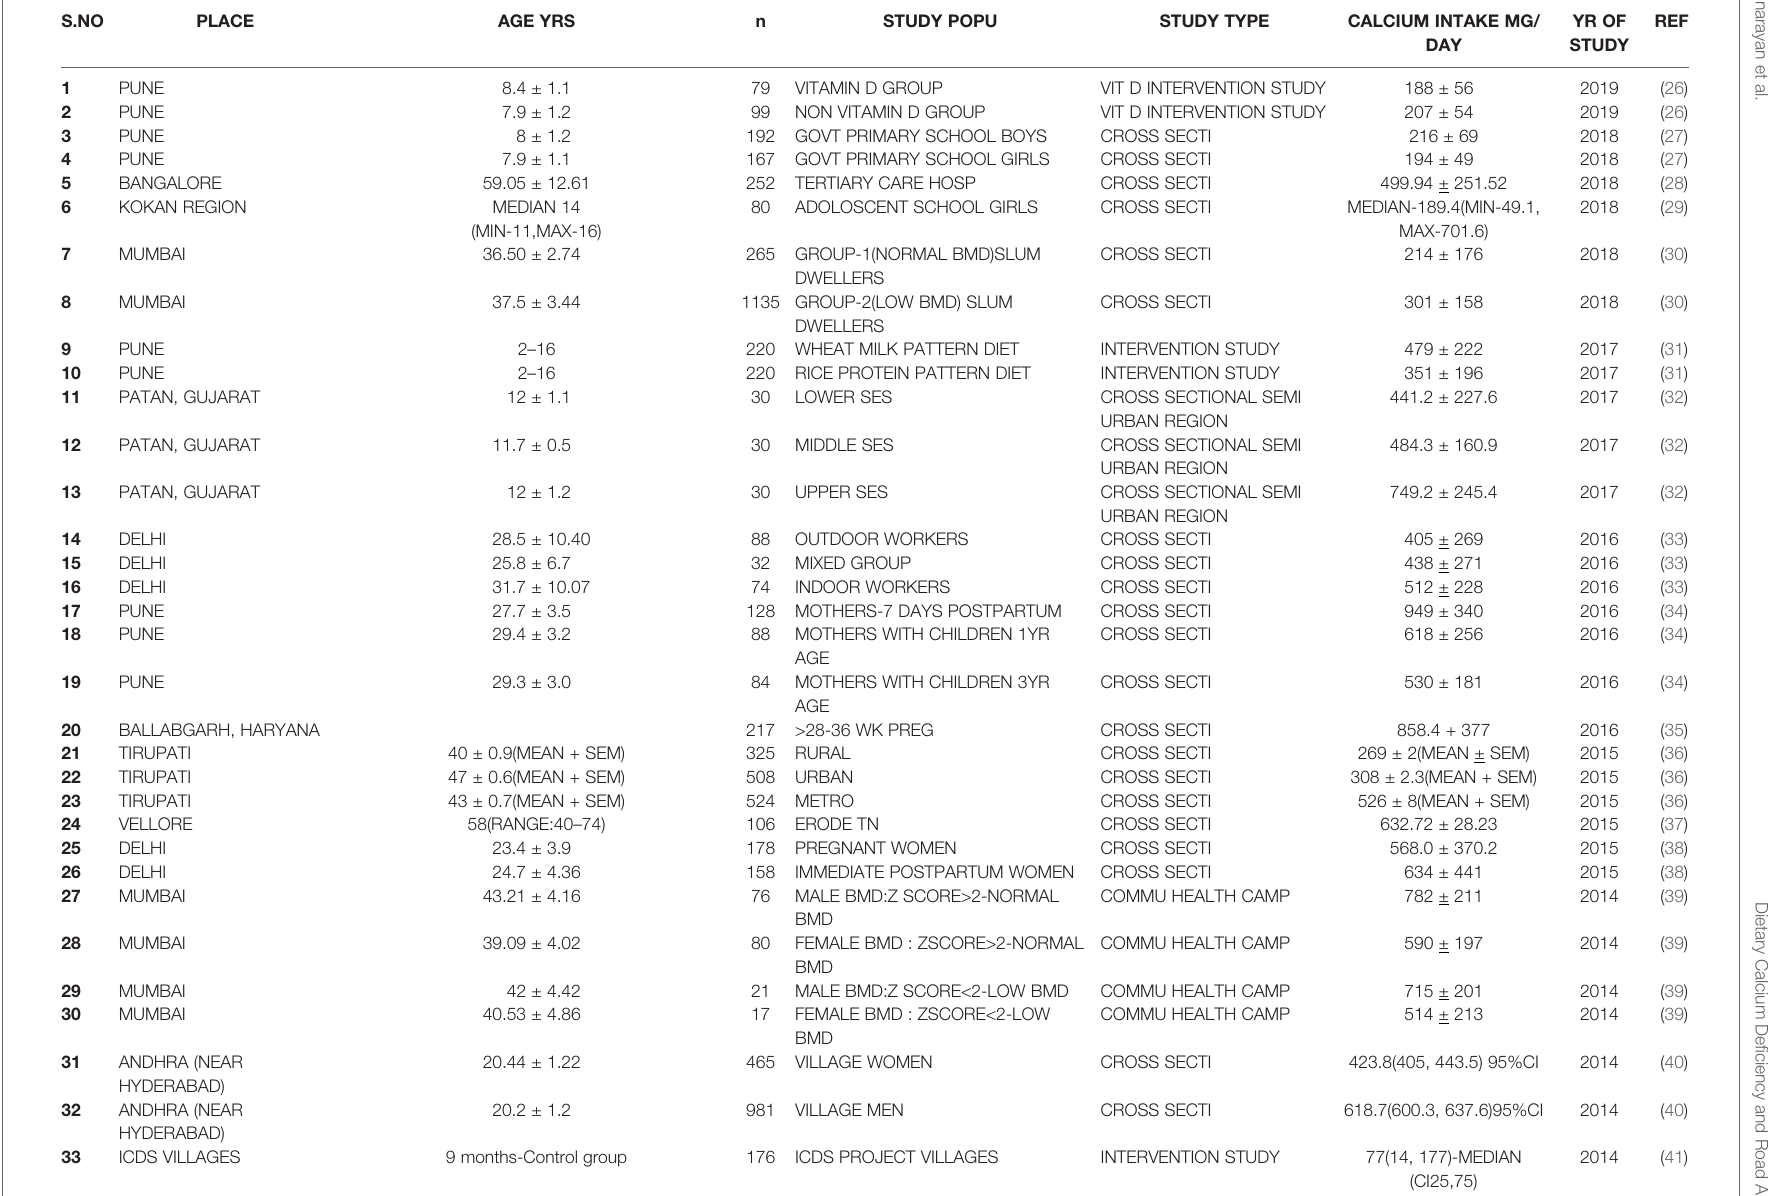
TABLE 2 | Table showing dietary calcium intake of different age groups and various study population across the country from 1999 to